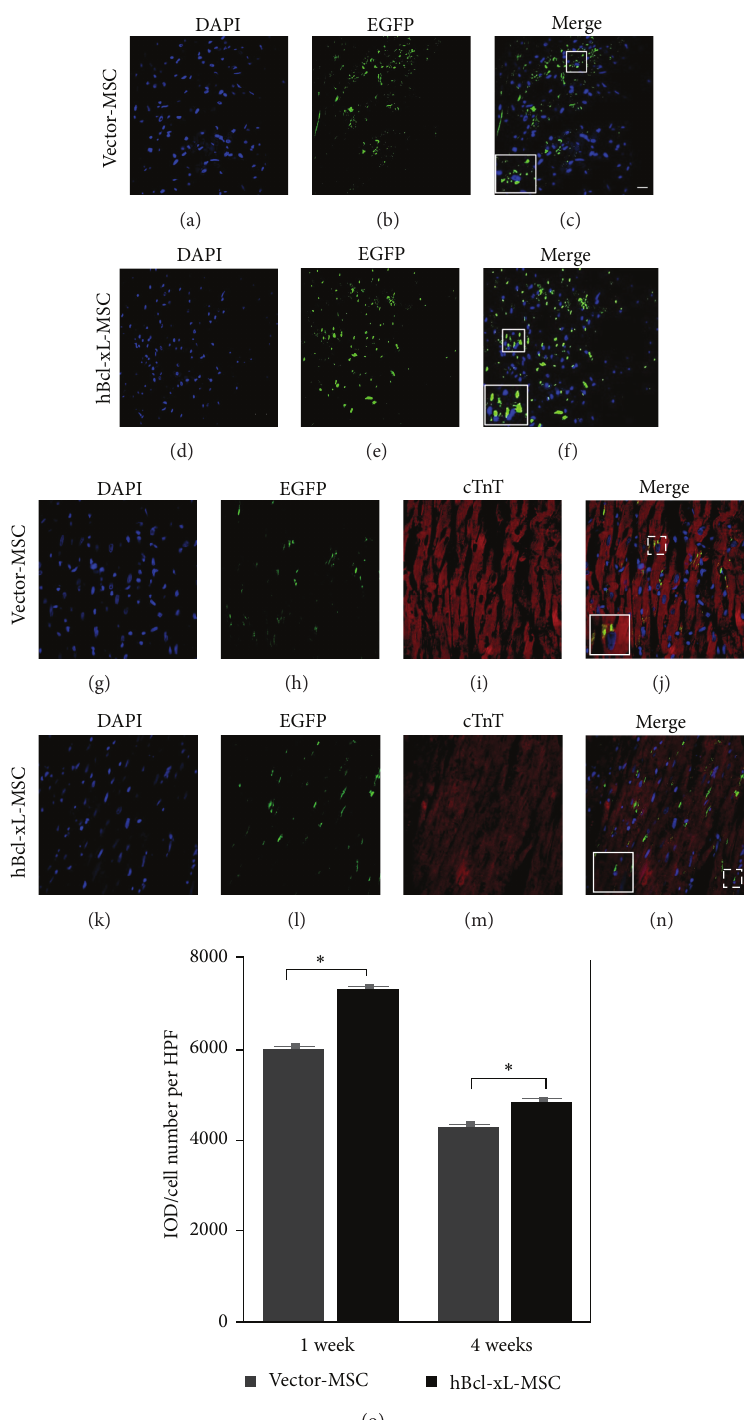
Figure 5: Engraftment of transplanted MSCs into infarcted myocardium. ((a)–(n)) Evaluation of MSC engraftment into the ischemic heart muscle at 1 week ((a)–(f)) and 4 weeks ((g)–(n)) after vector-MSCs ((a)–(c) and (g)–(j)) or hBcl-xL-MSCs ((d)–(f) and (k)–(n)) transplantation. Cell nuclei were stained with DAPI ((a), (d), (g), and (k)). The grafted MSCs were detected by EGFP signals ((b), (e), (h), and (l)) which appeared as irregular patches due to the cytoplasmic distribution of EGFP. The expanded squared areas in (c), (f), (j), and (n) indicatetheMSCengraftmentswhere theEGFP signalscolocalized with DAPI. Myocardium was showed byTroponin Tstaining4weeks after cell injection ((i) and (m)). (o) MSC engraftment in vector-MSC group (dark grey bar) and hBcl-xL-MSC group (black bar) was presented as the ratio of IOD and total cell number per HPF. Values are mean ± SD ( 𝑛 = 6 , ∗ 𝑃 < 0.01 ). EGFP: enhanced green fluorescent protein; DAPI: 4,6-diamino-2-phenyl indole; IOD: integral optical density; HPF: high-power field. Scale bar represents 50 𝜇 m (c) and 30 𝜇 m (j),